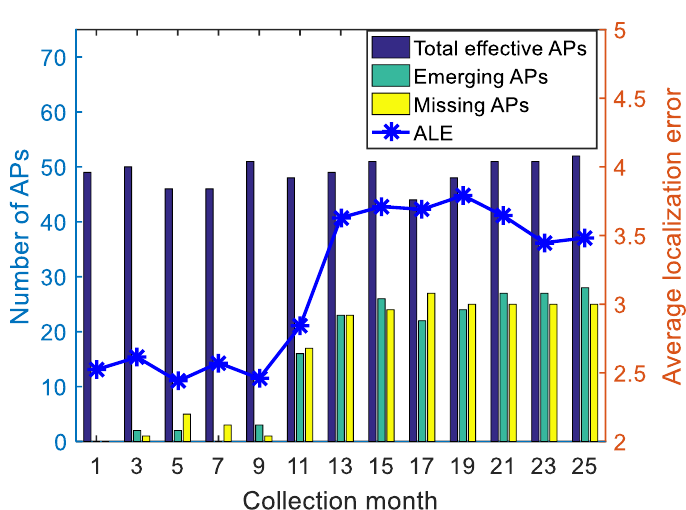
Figure 3. Layout of the experimental testbed.